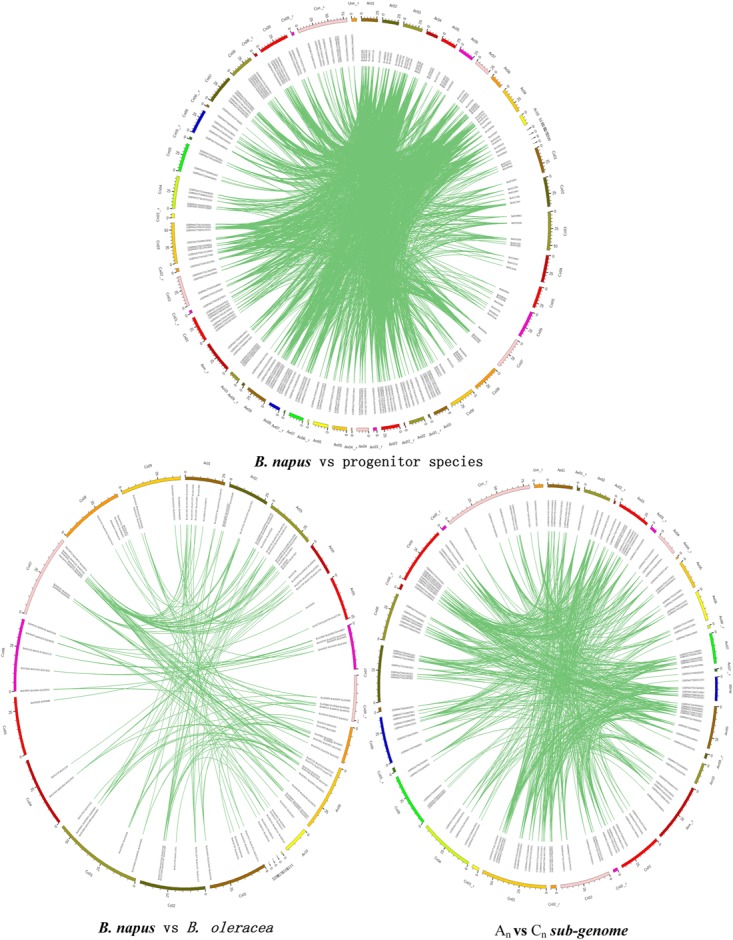
NBS-encoding gene homologs between the B. napus, B. Rapa, and B. oleracea genomes. Colored bars represent chromosomes of the three species. Green lines indicate the relationships of homologous gene pairs between genomes.